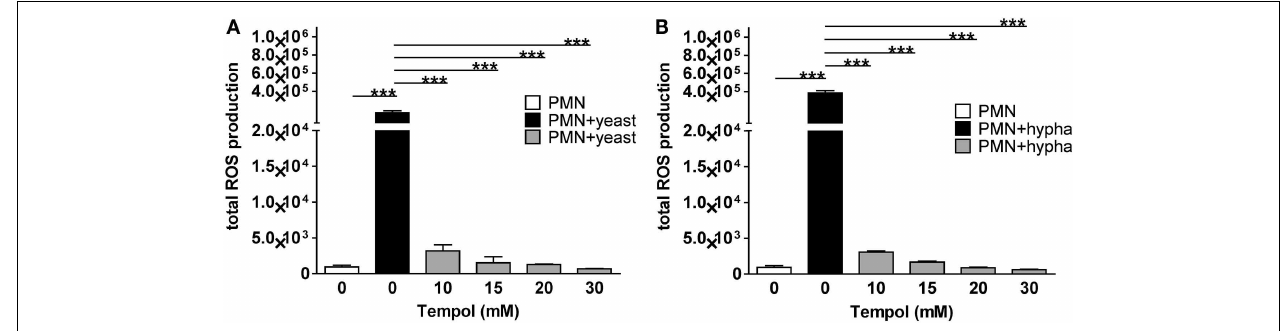
and hyphal cells (B) , respectively.White bars: unstimulated PMN, black bars: PMNs infected with C. albicans , gray bars: PMNs treated with different concentration ofTempol prior to stimulation with fungi. Significance was analyzed byTukey one-way ANOVA (*** P ≤ 0.001). One representative experiment out of three independent experiments with three different donors is shown. Data are presented as means of three technical replicates ± SD.